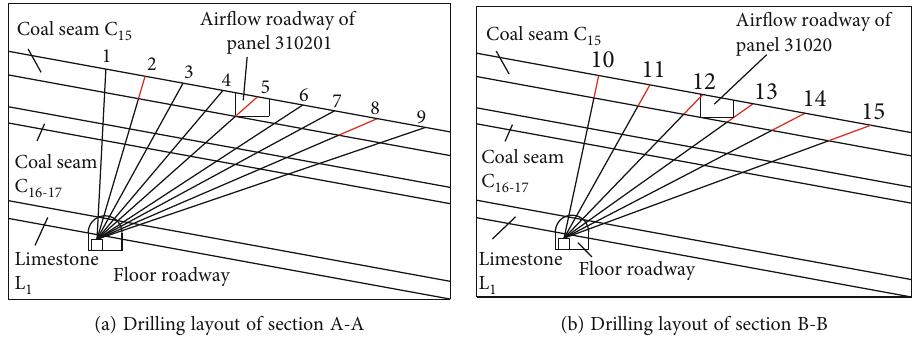
Figure 4: Section of gas extraction boreholes drilling from the fl oor roadway, modi fi ed from literature [30].